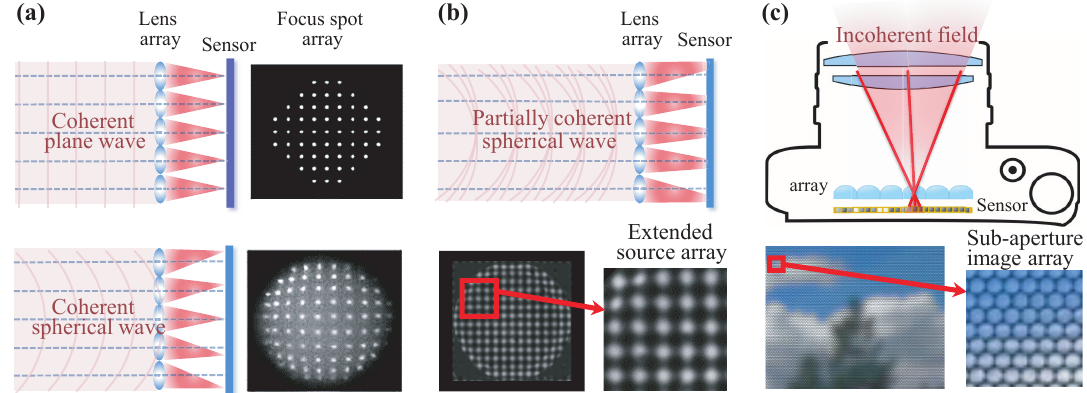
Figure 22. Principle of the Shack–Hartmann sensor and light field camera. ( a ) for coherent field, the Shack–Hartmann sensor forms a focus spot array sensor signal; ( b ) for a partially coherent field, the Shack–Hartmann sensor forms an extended source array sensor signa; ( c ) for incoherent imaging, the light field camera produces a 2D sub-aperture image